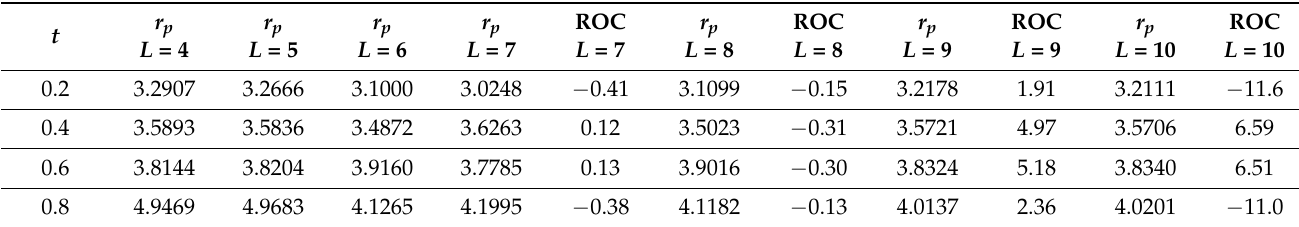
Table 12. The values of r p and rate of convergence (ROC) at different points for k = 0 and various values of L by sine– cosine